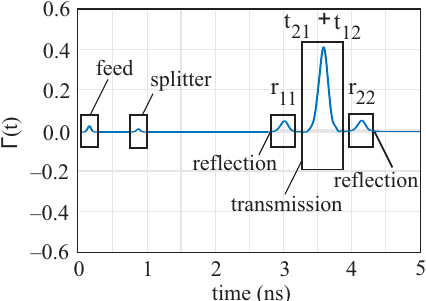
Figure 7. Measured time domain signal τ of a Teflon sample.